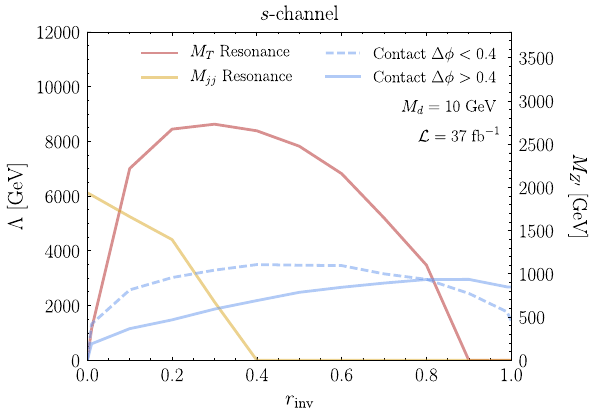
Fig. 2 Estimates of the projected limits for the s -channel model. The ‘contact’ limit uses a mono-jet search strategy, where (cid:7)φ is the angle between the missing transverse energy and the closest jet. Figure taken from